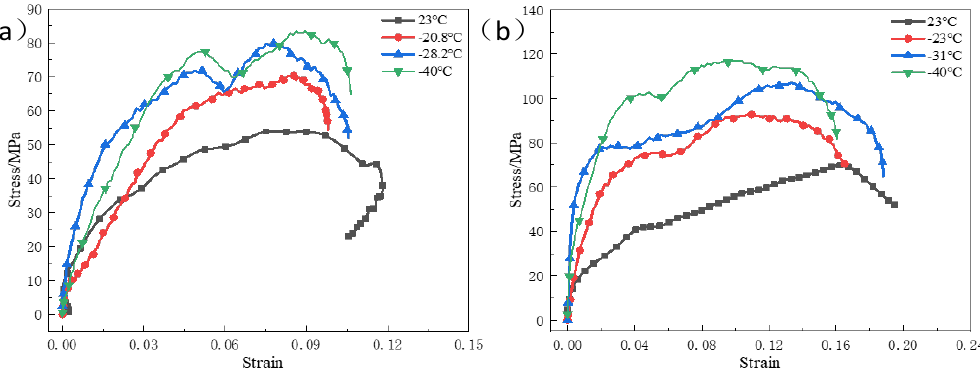
Figure 7. The specimens after dynamic compression at different strain rates at 20 °C.